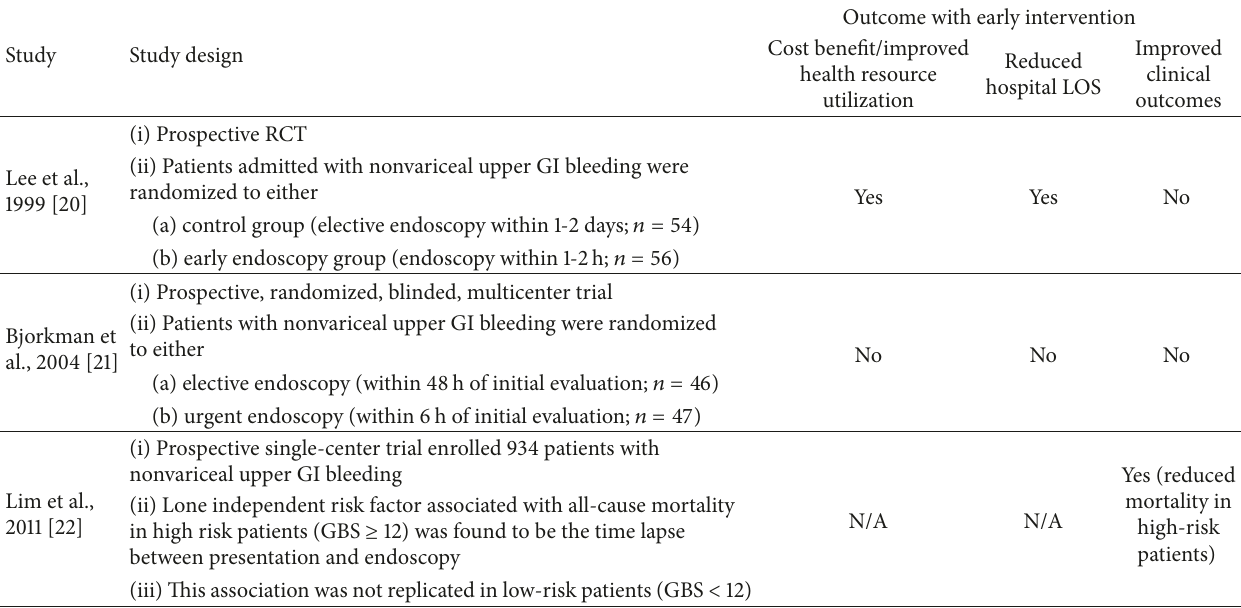
Table 5: Analyses of benefits associated with early intervention in patients with GI bleeding.